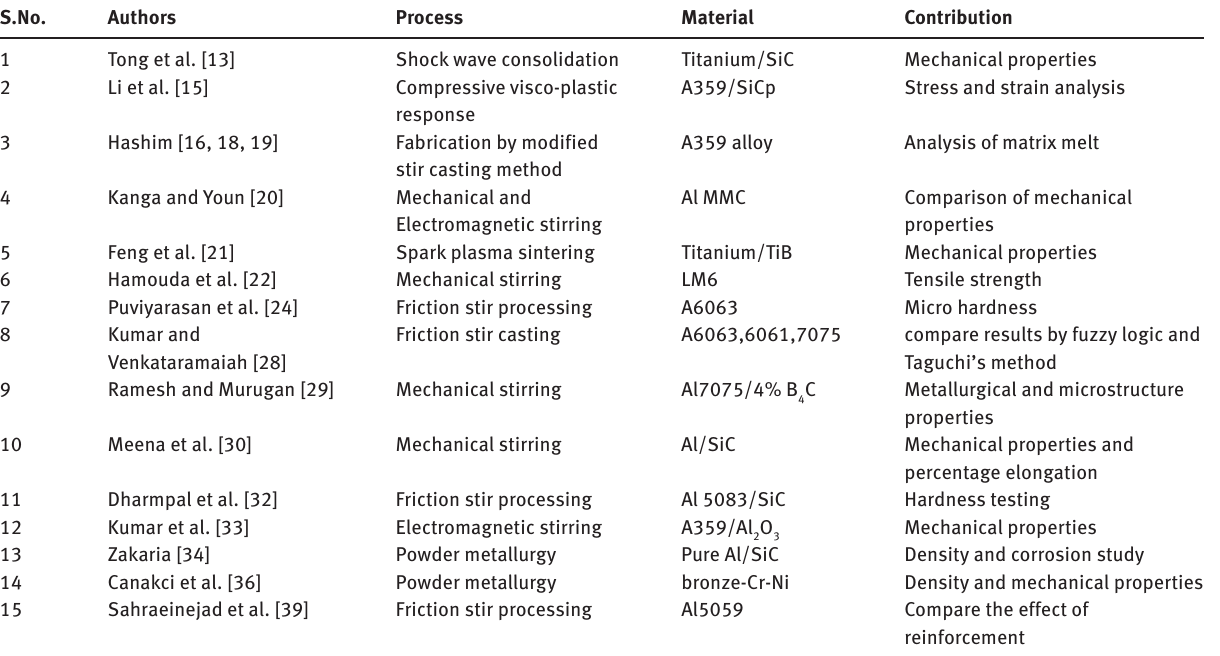
Table 2: Evaluation of metal matrix composite.